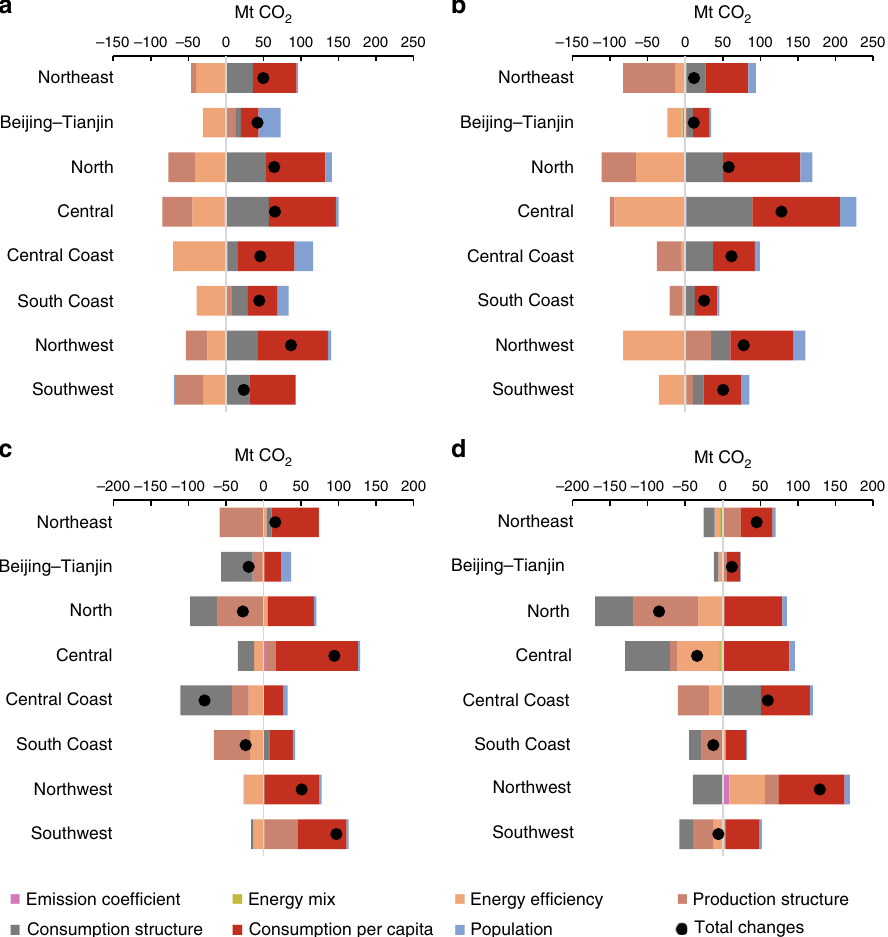
Fig. 2 Contributions of different factors to changes in domestic in fl ow and out fl ow in China. a In fl ow changes from 2007 to 2010, b Out fl ow changes from 2007 to 2010, c In fl ow changes from 2010 to 2012 and d Out fl ow changes from 2010 to 2012. Mt CO 2 means million tonnes of carbon dioxide. Emission coef fi cient is carbon emissions per unit of energy consumption, and energy ef fi ciency is energy consumption per unit of total